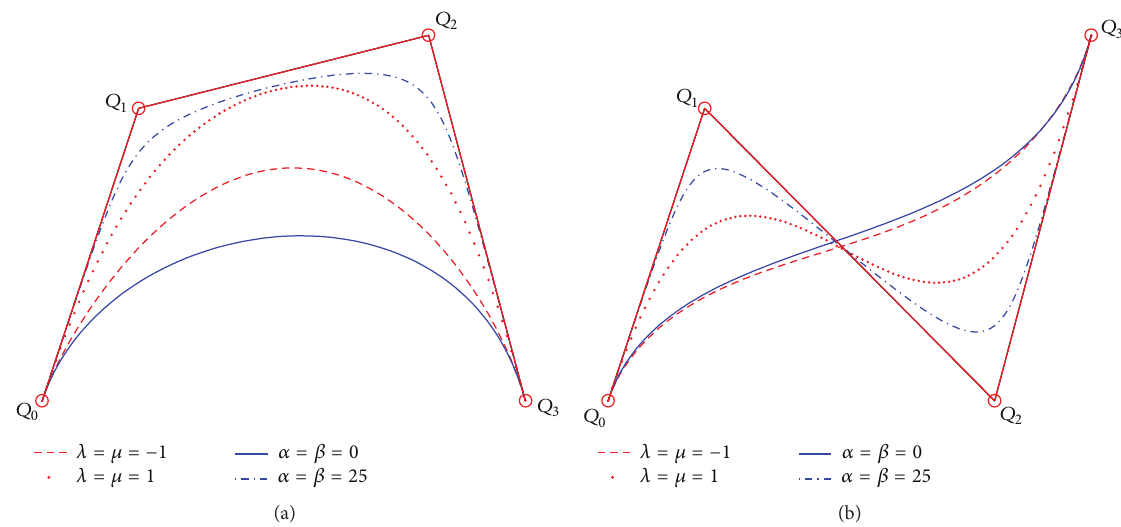
Figure 5: Comparisons between the quartic rational Said-Ball-like curves and the cubic trigonometric B´ezier curves with two shape parameters 𝜆 and 𝜇 given in